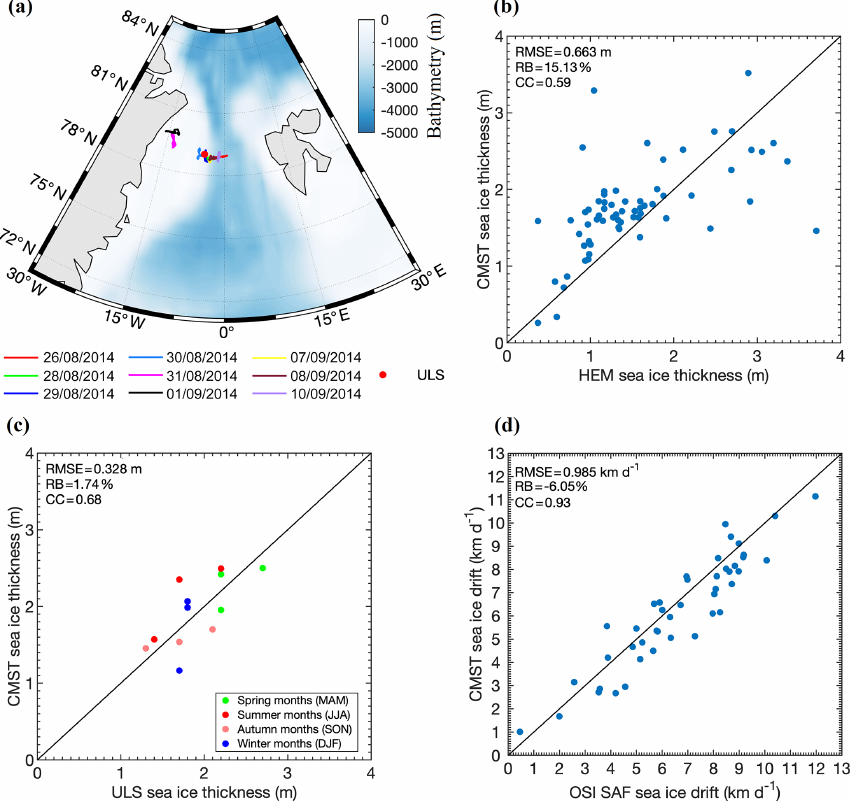
Figure 2. (a) The trajectories of nine separate flights of HEM measurement campaigns carried out in the Fram Strait and the red dot denotes the site of ULS. Scatter plots of (b) daily mean sea ice thickness derived from CMST and HEM data, (c) monthly mean sea ice thickness derived from CMST and ULS data, and (d) monthly average sea ice drift based on CMST and OSI